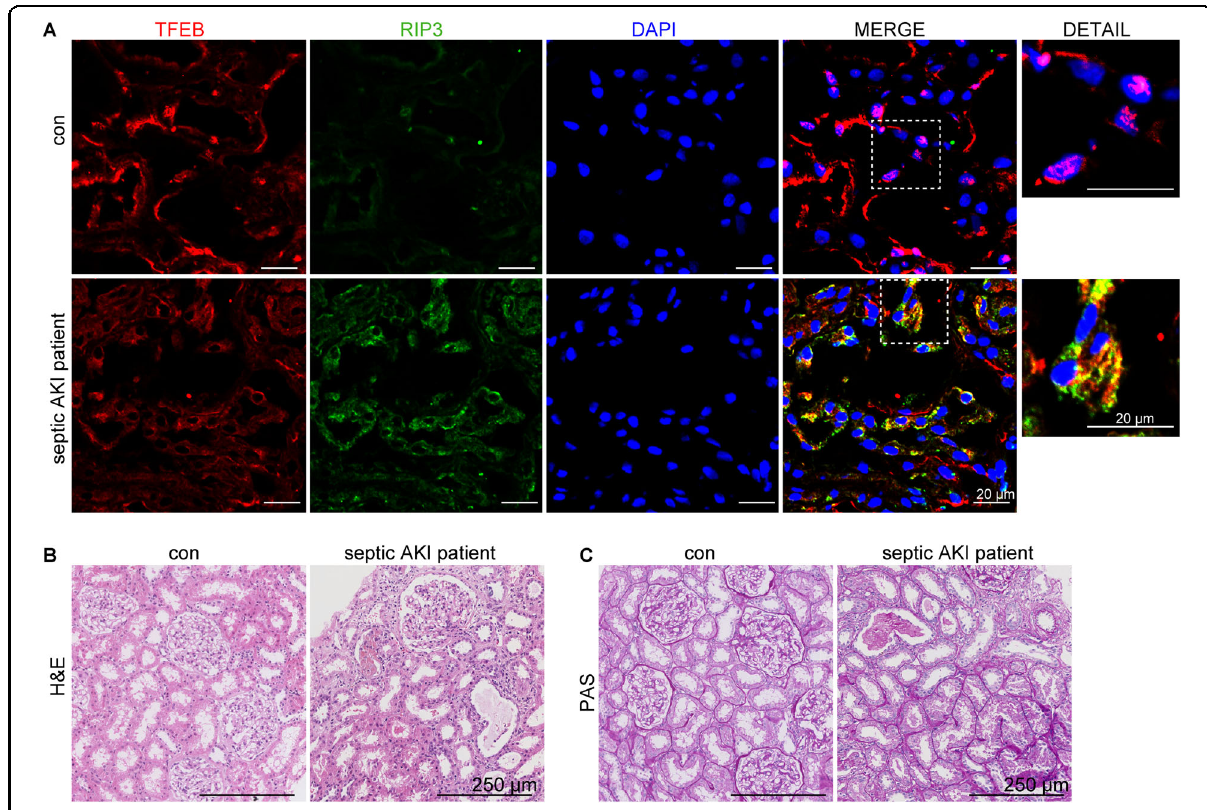
Fig. 8 RIP3-TFEB pathway was involved in the patient with septic AKI. A Immuno fl uorescence staining for TFEB (red), RIP3 (green), and DAPI (blue) of kidney specimens from one control subject and one patient with septic AKI. The RIP3 expression was enhanced, whereas the TFEB nuclear translocation was inhibited in the renal tubular cells in the septic AKI patient. TFEB colocalized with RIP3 in the cytosol in the renal tubular cells in the septic AKI patient. Scale bar = 20 μ m. B , C Representative histology images of hematoxylin – eosin (H&E) staining and periodic acid – Schiff (PAS) staining of renal tissues from the septic AKI patient and the control subject. Scale bar = 250 μ